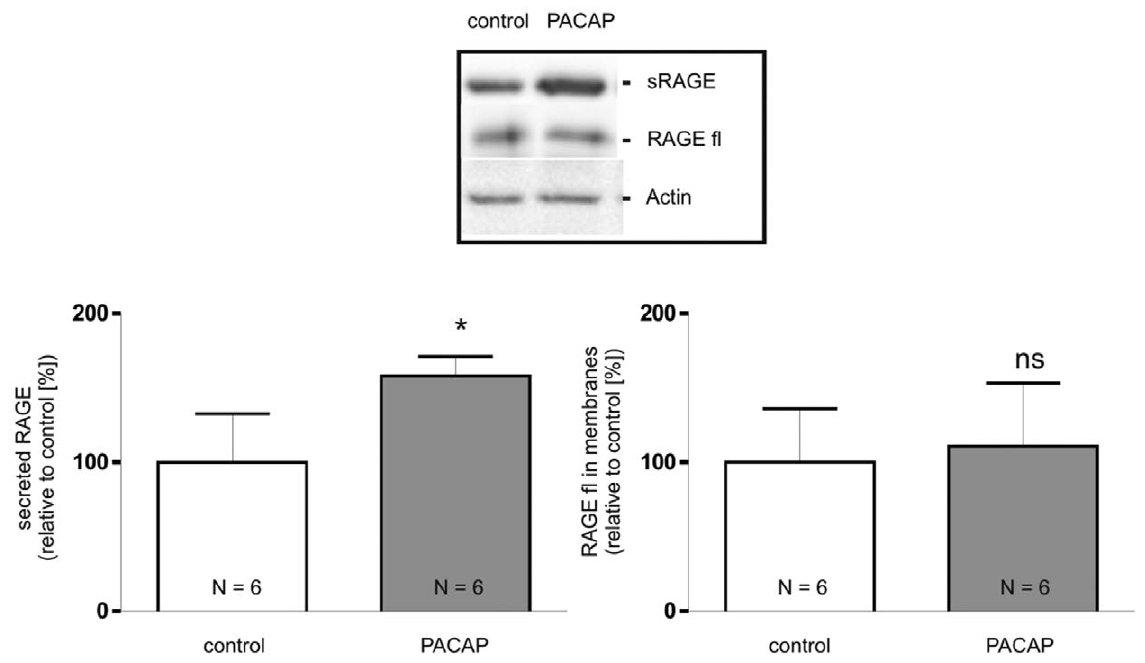
Figure 16. Analysis of PACAP-induced RAGE shedding invivo . Mices (N=6) were treated intranasally with PACAP-38 for 3 months. Afterwards mouse lungs were dissected and membrane proteins and soluble proteins were separated following tissue homogenization by ultracentrifugation. Secreted RAGE (sRAGE) and full-length RAGE (RAGE fl) were detected by Western blotting using an antibody directed against mouse RAGE (MAB1179) followed by an anti-rat antibody labeled with horse radish peroxidase, as loading control actin was detected. Shown are the mean effects 6 S.D., significance was determined by the Student’s unpaired t test (ns = P . 0.05; * = P , 0.05).